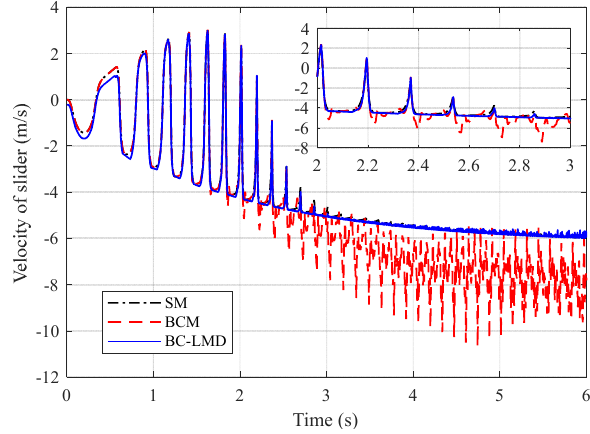
Figure 6. Lower bound of the velocity of the slider.